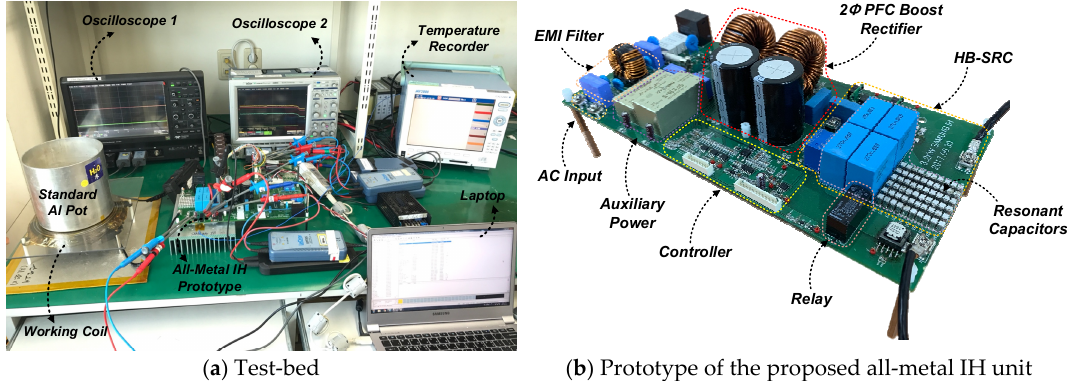
Figure 15. Prototype of the proposed all-metal domestic IH system.